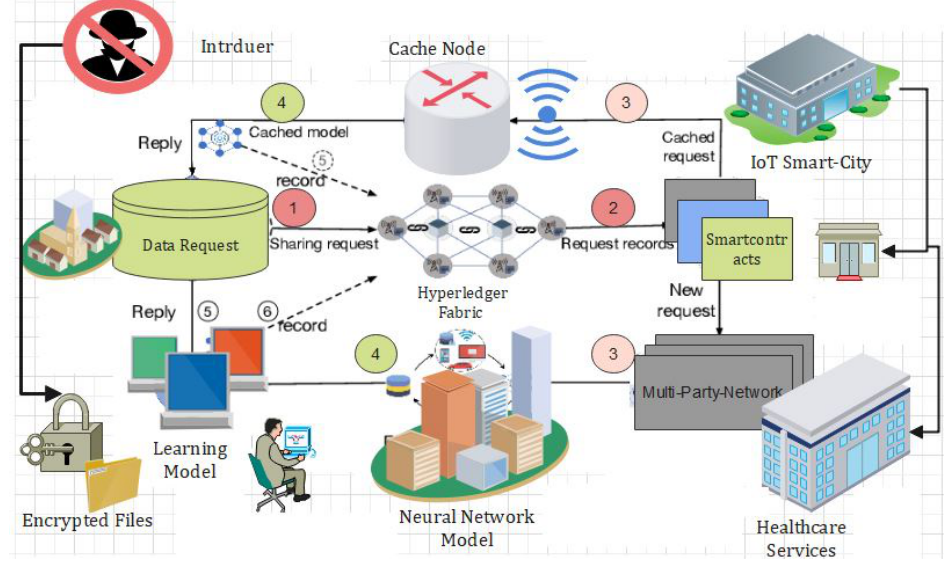
Figure 5. Performance comparison of the proposed framework and